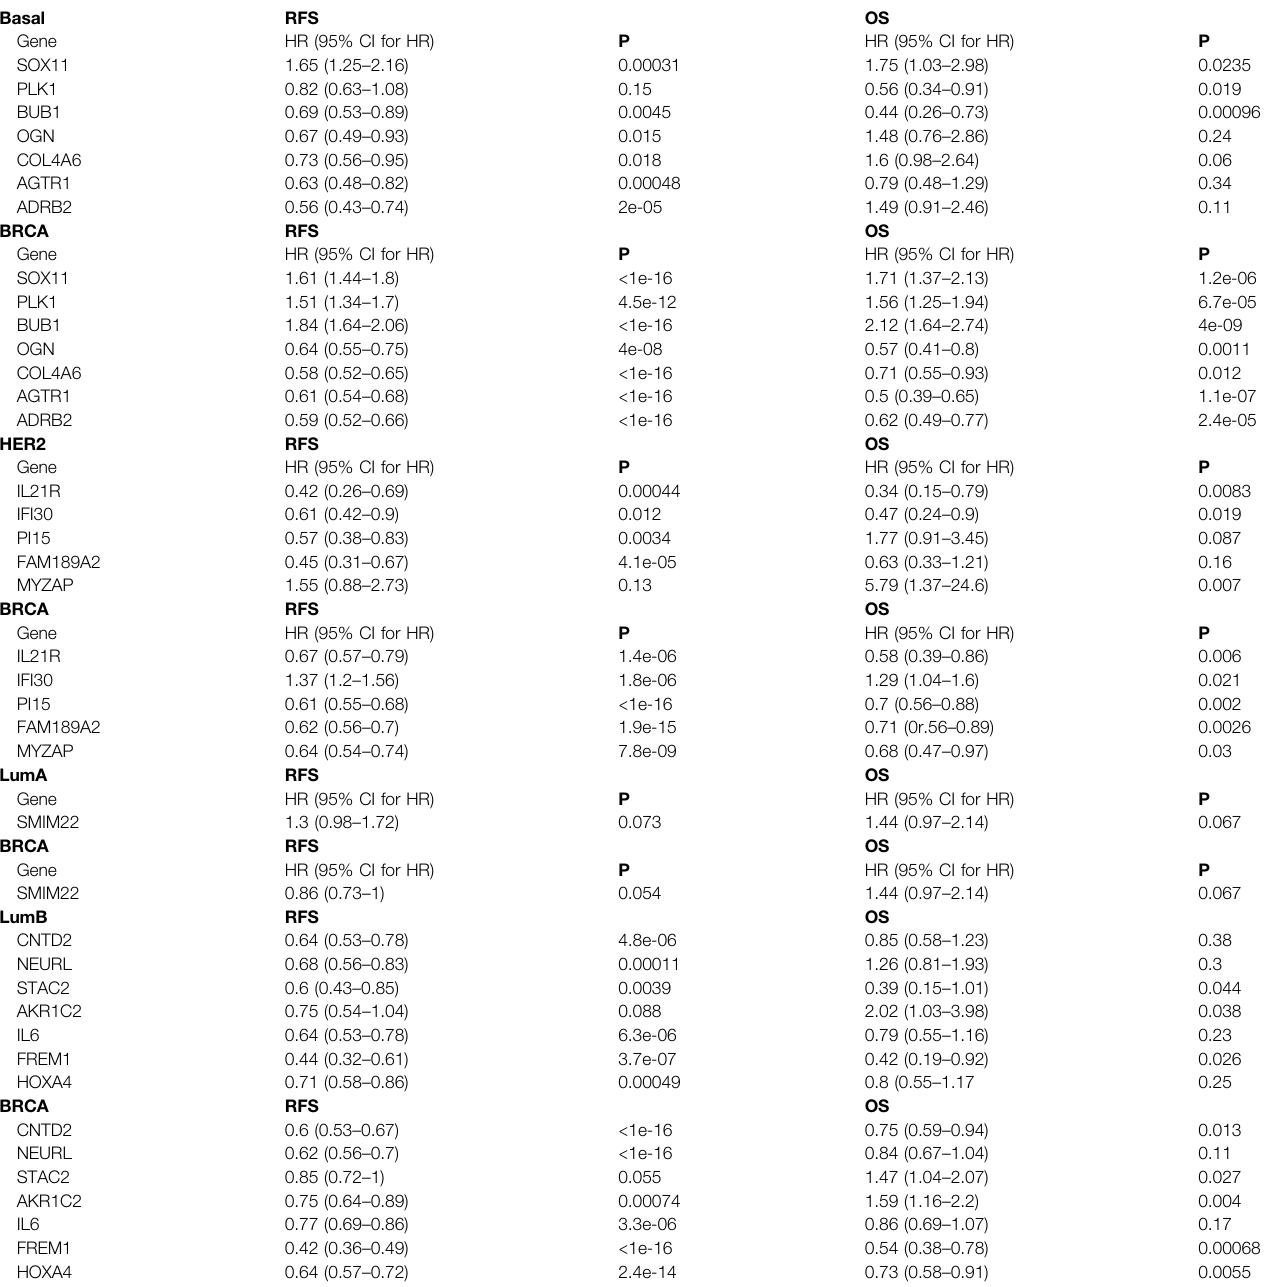
TABLE 5 | Prognostic value of the key speci fi c DEGs in Basal subtype, Her2 subtype, LumB subtype and total breast cancers. Basal RFS OS Gene HR (95% CI for